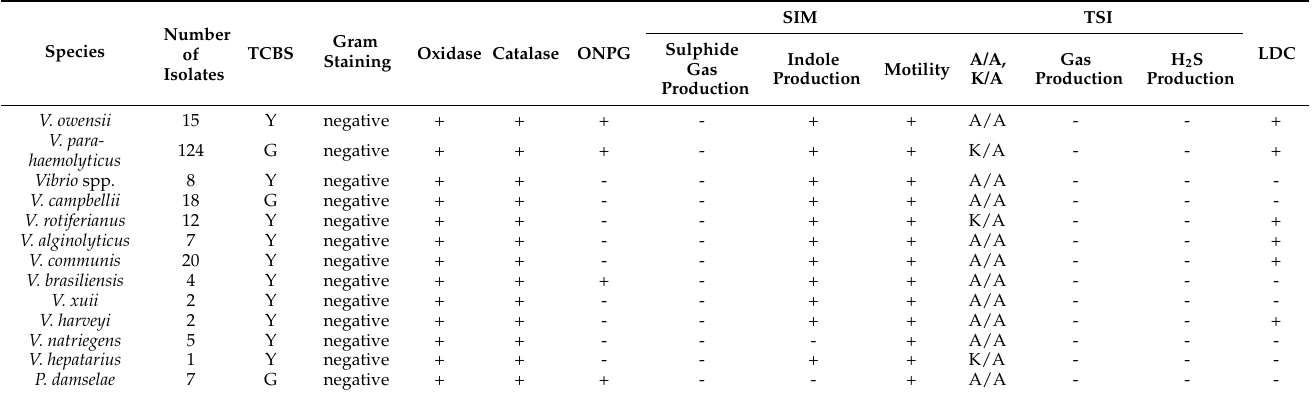
Table 3. Biochemical properties of Vibrio spp. isolated from cultured shrimp in Peninsular